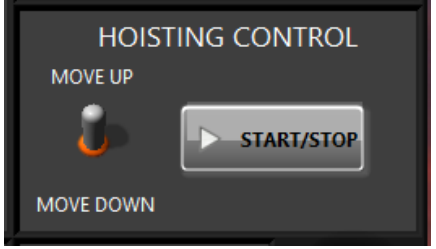
Figure 18. Hoisting mechanism control panel.